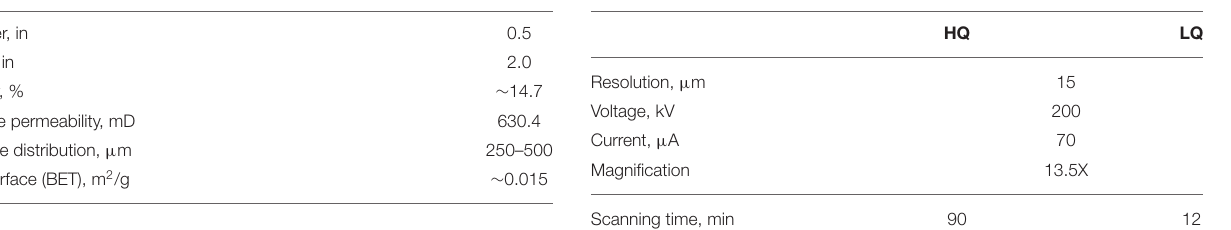
TABLE 2 | Properties of the porous core sample (Niu, 2021). TABLE 3 | MCT scanning